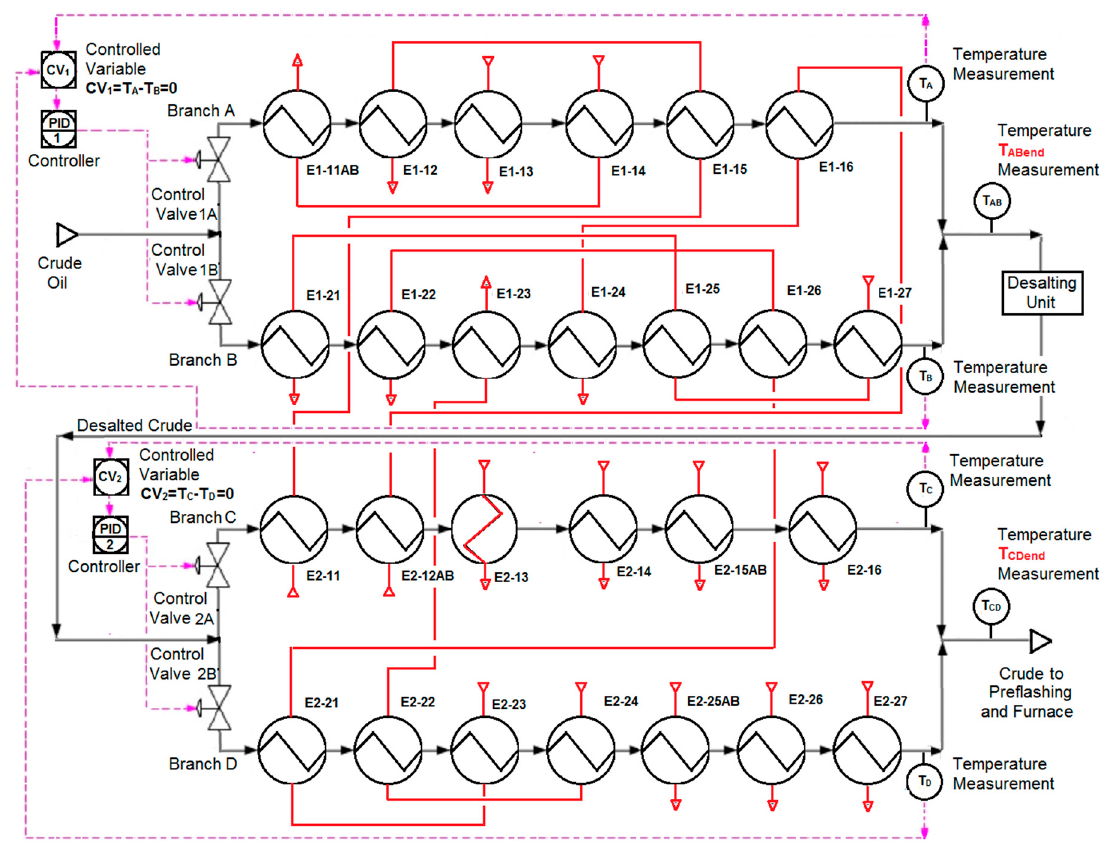
Figure 2. Scheme of the HEN with the PID control loops numbered 1 and 2.